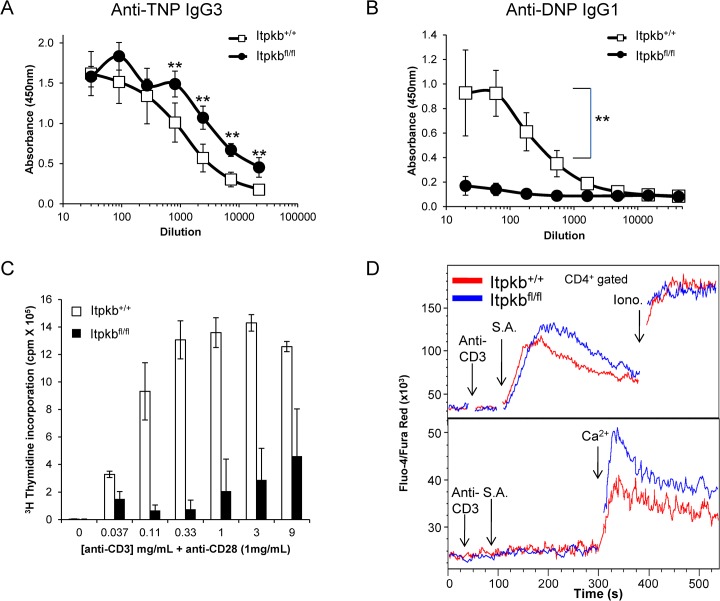
Itpkb is required for T cell function by negatively regulating SOC channels.WT and Itpkb
fl/fl mice were immunized with either the T-independent antigen, TNP-Ficoll, or the T-dependent antigen DNP-KLH. ELISA of TNP-specific IgG3 (A) or DNP-specific IgG1 (B) antibody responses on day 12 following immunization. Data from one representative experiment is shown (**, P < 0.01). In vitro, Itpkb-deficient mature lymphocytes are diminished in their proliferative capacity as measured by thymidine incorporation of purified CD4+ cells following stimulation with various concentrations of anti-CD3 plus anti-CD28 (C). The data from one representative experiment are shown with values representing the mean counts per minute (cpm) ± SEM. *P < 0.05. Analysis of Ca2+ responses using the Ca2+ sensitive dyes Fluo-4 and Fura Red were evaluated after cross-linking the antigen receptor either in the presence or absence of exogenous Ca2+. Splenocytes gated on CD4 were treated with anti-CD3-biotin, followed by cross-linking with streptavidin (S.A.) in the presence of exogenous calcium (top panel), or in the absence of exogenous calcium, followed by calcium re-addition to examine SOC channel function (bottom panel). Ionomycin (Iono.) stimulation was used at the end of each run to control for equivalent dye loading. Data is shown as the mean fluorescent ratio of Fluo-3 and Fura-Red. Representative data of three independent experiments are shown.